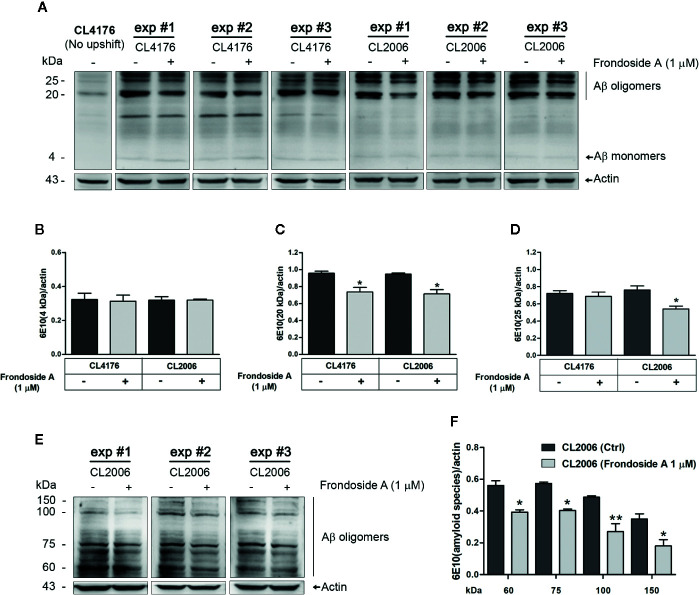
Effect of frondoside A on Aβ species in C. elegans strains. (A) Representative western blot of low molecular weight Aβ species in CL4176 and CL2006 worms fed with either vehicle or 1 µM frondoside A and detected by anti-Aβ antibody (6E10) or anti-actin. Quantification of Aβ monomers at 4 kDa (B), Aβ oligomers at 20 kDa (C), and 25 kDa (D) in both CL4176 and CL2006 fed with frondoside A or vehicle was analyzed by using Image J software. (E) Representative western blot of high molecular weights of Aβ species in untreated and treated CL2006 worm tissues as detected by 6E10 antibody. The Aβ oligomer bands at 60, 75, 100, and 150 kDa were quantified (F). The black lines indicate various molecular sizes of Aβ oligomers. The arrows indicate Aβ monomers (4 kDa) or actin (43 kDa). Quantitative data are expressed as mean ± SD of the indicated band density from three independent experiments (exp) with 1,000 worms in each group. *p < 0.05 and **p < 0.01 vs. control group.